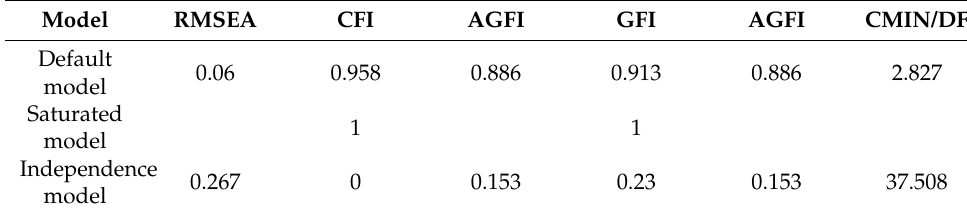
Table 3. CFA standard values.